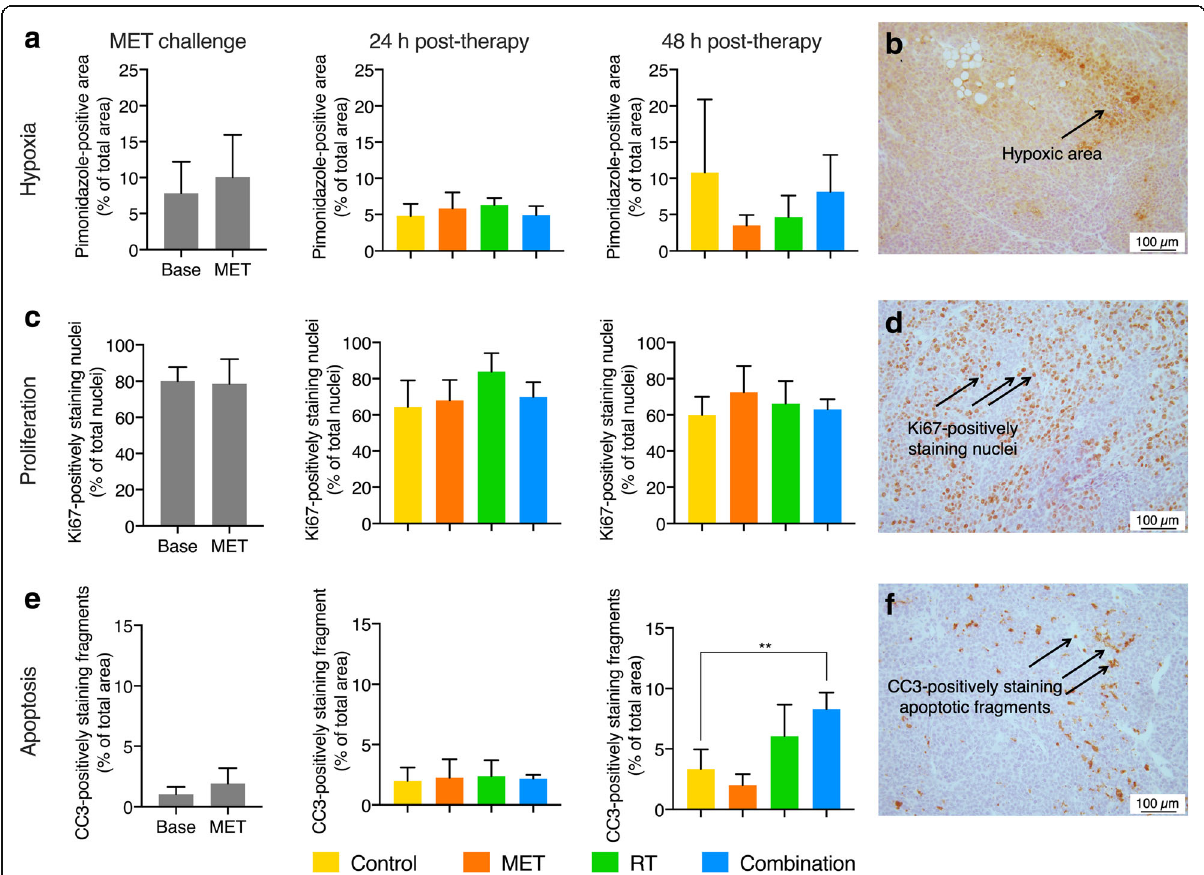
Fig. 5 Histology satellite study. a No major differences in pimonidazole staining were observed between the different therapies at the different points in time. b Representative pimonidazole-stained tumor tissue of a metformin (MET)-treated animal. The arrow indicates a hypoxic area. c Same conclusions could be drawn for the Ki67 staining. d Representative Ki67-stained tumor tissue of a metformin-treated animal. Arrows indicate Ki67-positively staining nuclei. e 48 h post-therapy, the cleaved caspase-3 (CC3)-positive fraction was significantly increased in combination-treated tumors as compared to control. f Representative CC3-stained tumor tissue of a metformin-treated animal. Arrows indicate CC3-positively staining apoptotic fragments. **, p < 0.001; base, baseline; RT,